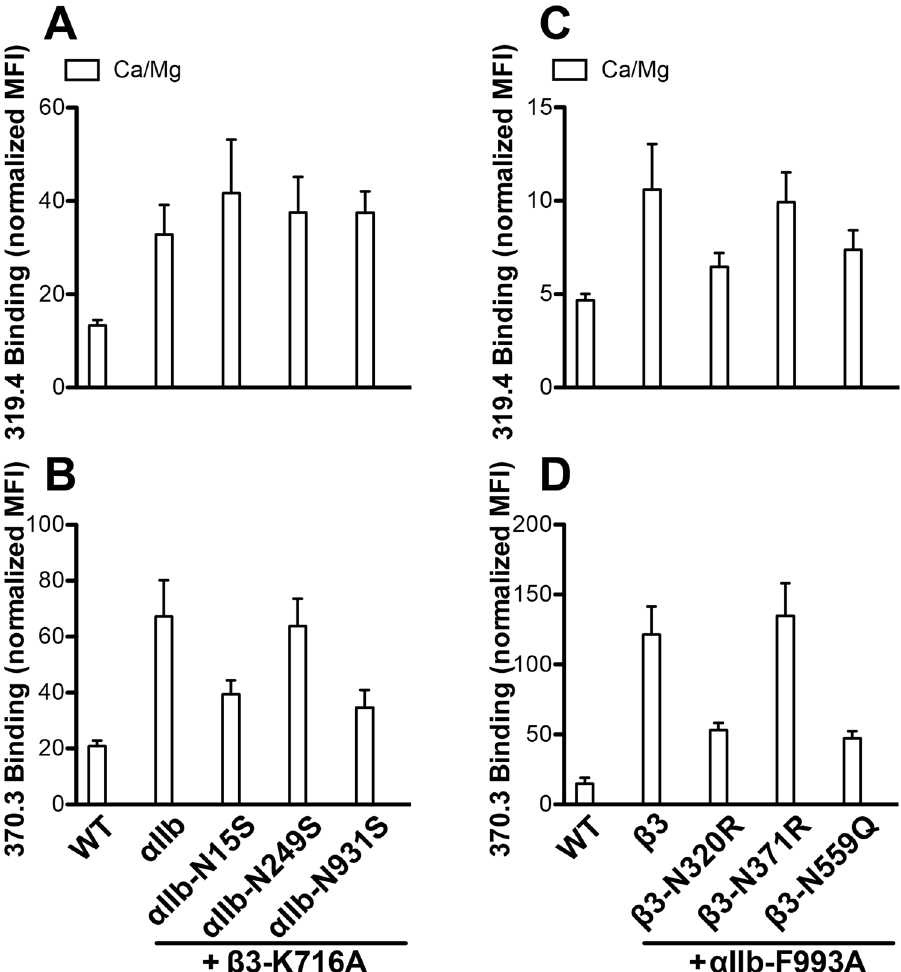
Figure 7. Effect of N-glycan deletions on the α IIb β 3 conformational change induced by inside-out activation. ( A , B) Binding of the anti- β 3 mAb 319.4 or anti- α IIb mAb 370.3 to the HEK293FT cells transfected with the α IIb WT or the glycan mutants and the active β 3 -K716A mutant, which mimics integrin inside-out activation. (C , D) Binding of the anti- β 3 mAb 319.4 or anti- α IIb mAb 370.3 to the HEK293FT cells transfected with the β 3 WT or the glycan mutants and the active α IIb -F993A mutant, which mimics integrin inside-out activation. Data are means ± s.e.m. (n =